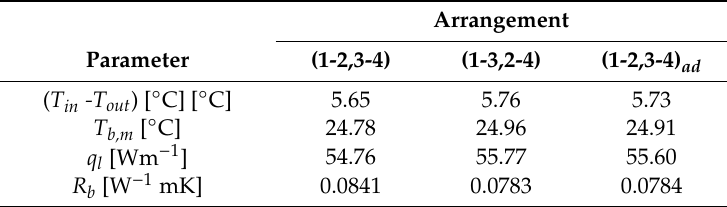
Table 5. E ff ects of thermal short-circuiting on relevant parameters of thermal